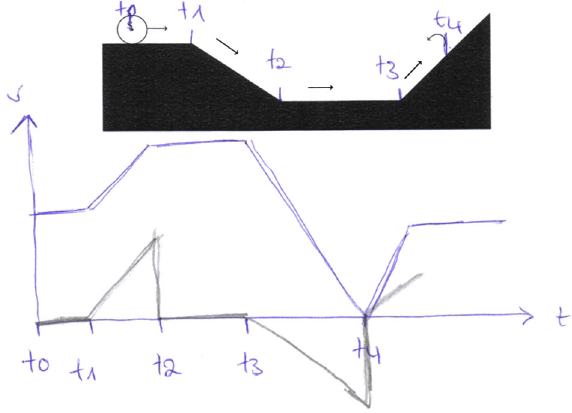
FIG. 4. Item 6 related sketch drawn by student L1 during the interview. Velocity-time graph was drawn first (ballpoint pen, blue), acceleration-time graph subsequently